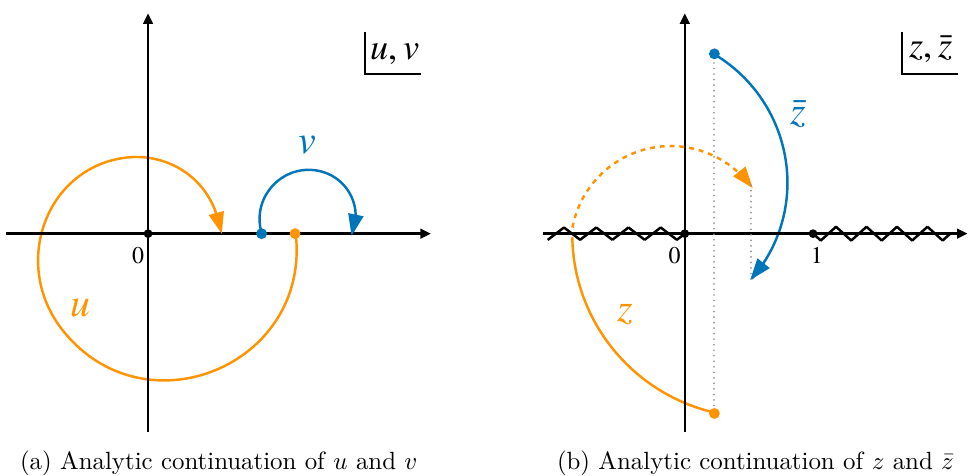
Figure 18. Analytic continuation to s -physical S -matrix configuration. Left: u takes a full clockwise turn around 0 while v does not. Right: the orange dashed curve indicates that z moves on the second Riemann sheet. Black dotted lines indicate that z and ¯ z are complex conjugate of each other at the starting point (corresponding to a Euclidean configuration) and the end point (corresponding to an S-matrix